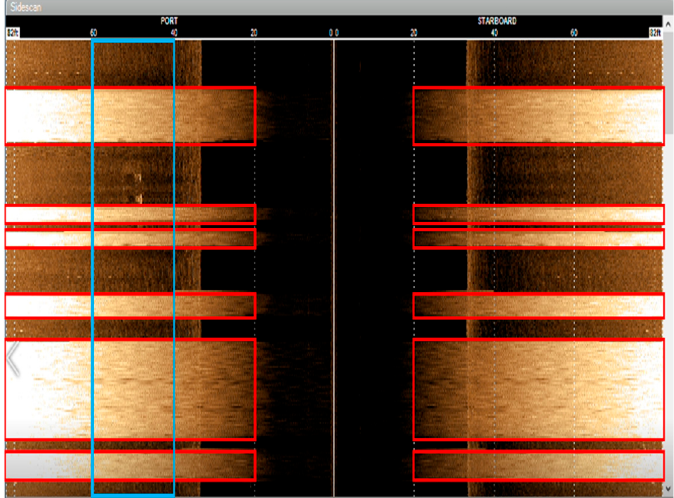
Figure 6. Reference image of Starfish 990F with intense banding from using an electric trolling motor. The red box represents the area of the image where the brightness was measured to quantify the noise in the horizontal direction. The blue box represents the area of the image where the brightness was measured to quantify the noise in the vertical direction. These same pixel areas were used in each image but only depicted here for clarity.